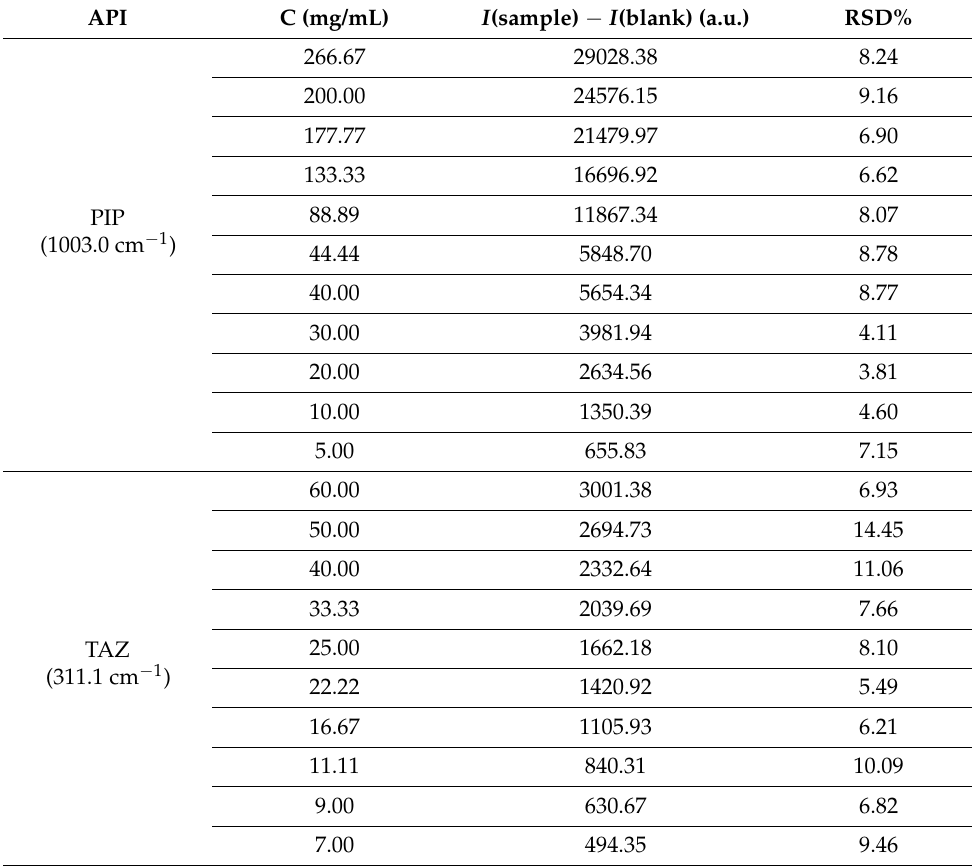
Table 4. Mean peak height values I1003(sample) − I1003(blank) and I311(sample) − I311(blank) and respective relative standard deviation (RSD) values corresponding to the six measurements taken from the six different marked areas on the commercial glass bottle. API C